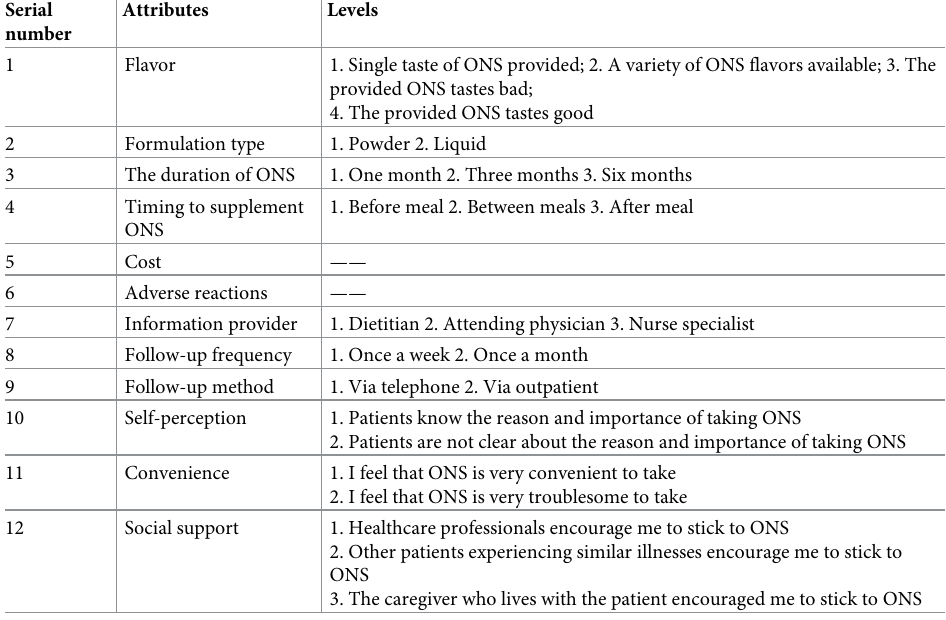
Table 2. Initial attributes and levels obtained from the literature